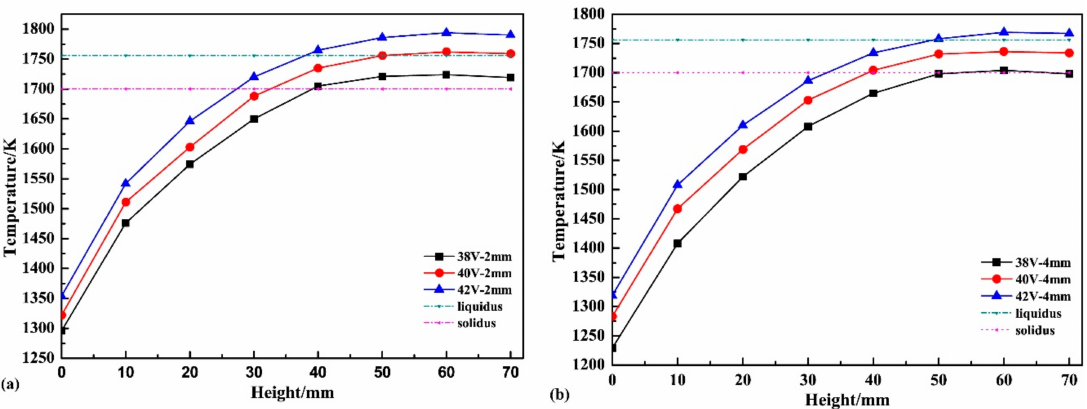
Figure 11. Temperature of points on the cross-section (M) at monitoring points with different voltage: ( a ) 2 mm, 270 mm; ( b ) 4 mm, 270